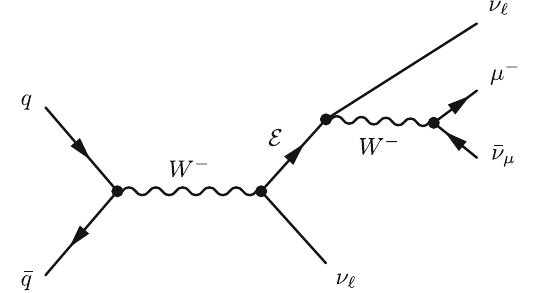
Fig. 3 Leading-order Feynman diagram for VLL single production. q and ¯ q corresponds to quarks originating from the initial protons and ν (cid:14) are the SM neutrinos